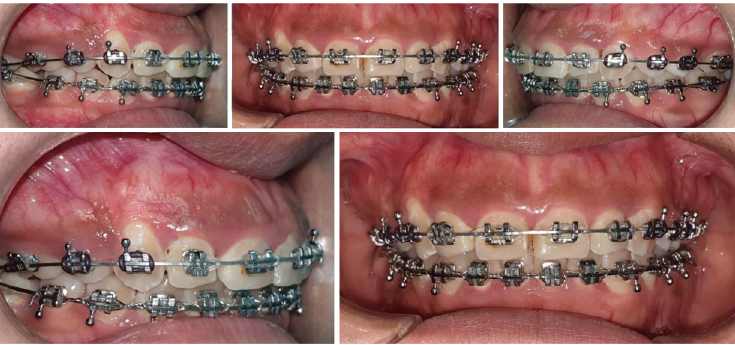
Figure 6: Finishing with coordinated 0 : 019 ″ × 0 : 025 ″ stainless steel